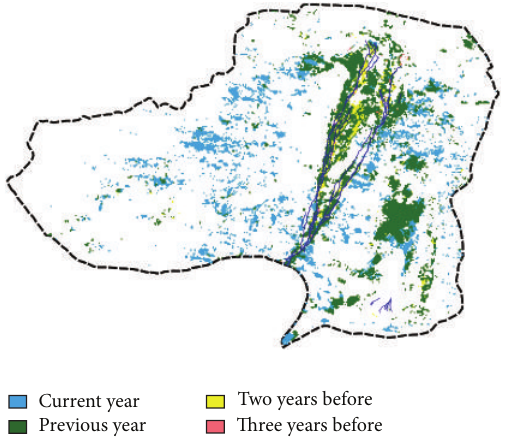
Figure 10: Time lag distribution between anomalies of NDVI and runoff at the Langxinshan station at the pixel